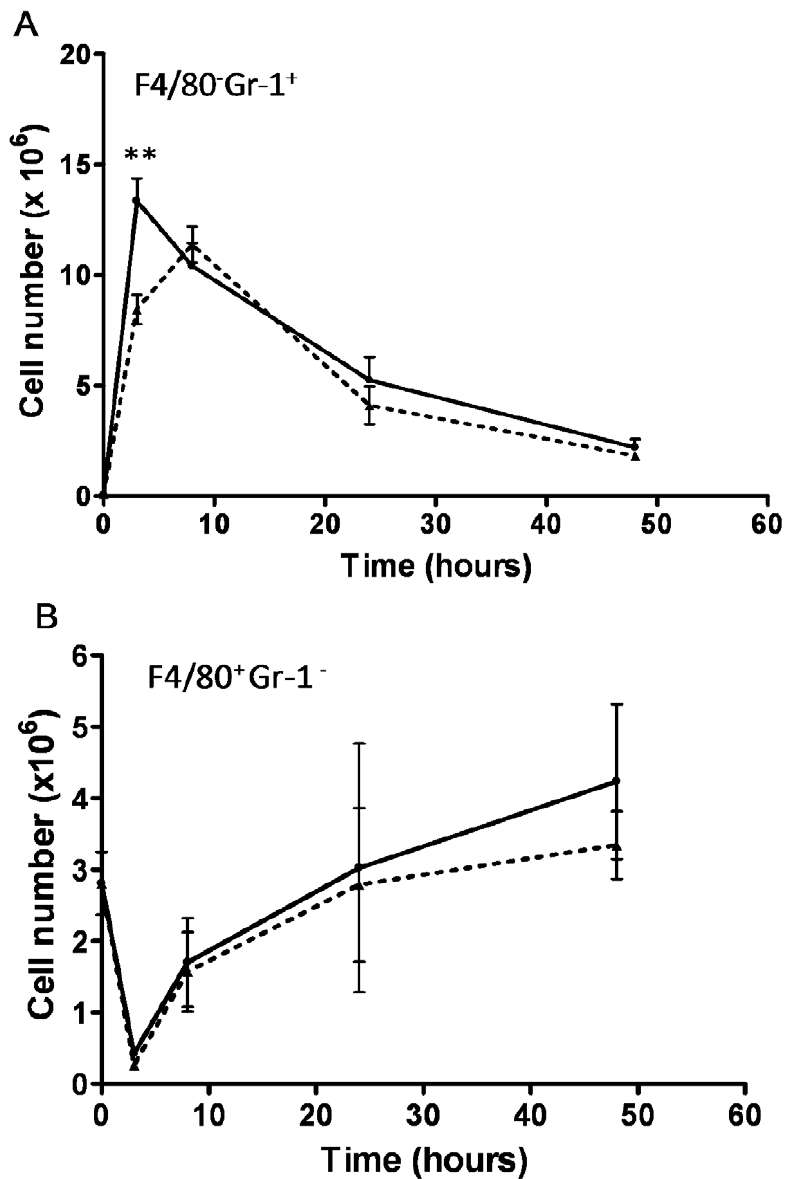
Figure 6. Intraperitoneal inflammatory response to C.albicans strain variants. Kinetics of neutrophils (A) and macrophages (B) in the peritoneal cavity following i.p. infection of BALB/c mice with 10 7 cells from strains 124A (solid line) and 140A (dashed lines). Cells were recovered by peritoneal lavage, and counting of leukocytes was performed by flow citometry. Statistically significant differences between results at 3, 8, 24 and 48 hours of infection, as evaluated by Student’s t test, are labeled with double asterisks ( P ,